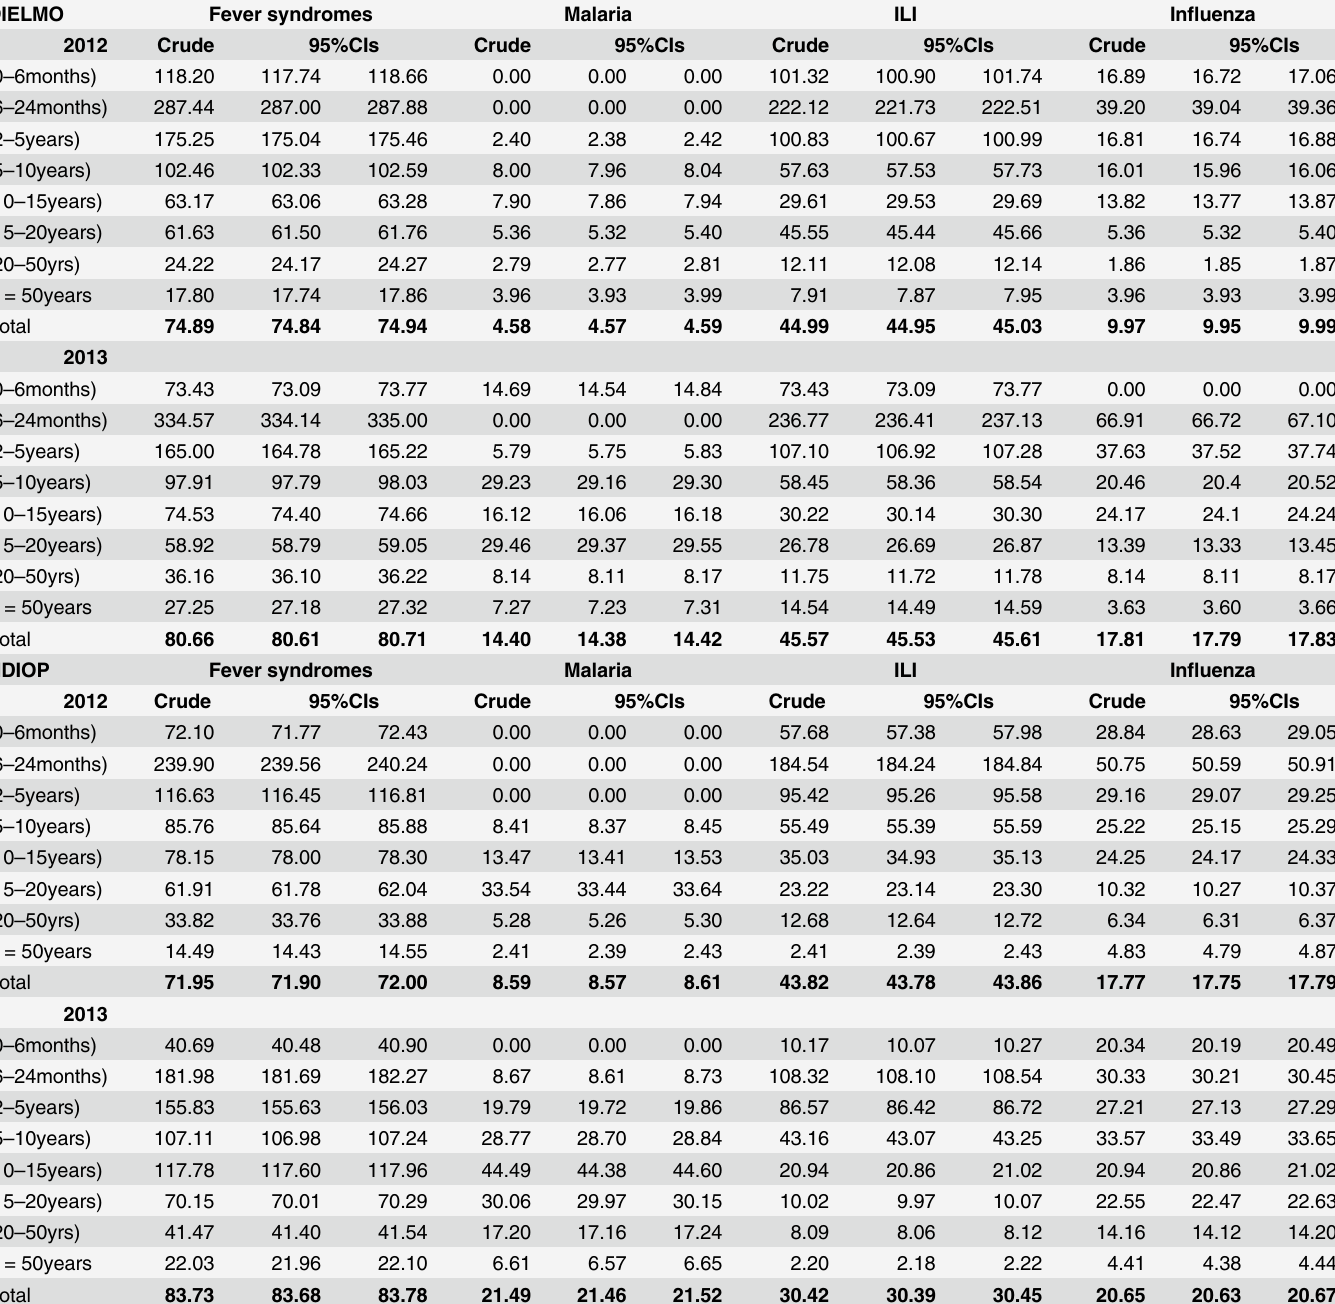
Table 2. Incidence of fever syndromes, malaria cases, ILI and influenza infection in Dielmo and Ndiop, January 2012 – December